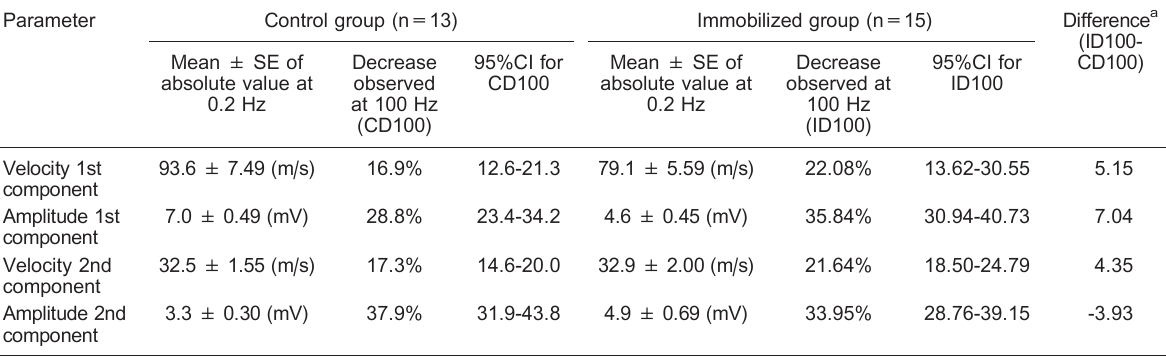
Table 1. Comparison of amplitude and velocity of the waves of the compound action potential (CAP) at 0.2 and 100.0 Hz for control vs immobilized conditions. Parameter